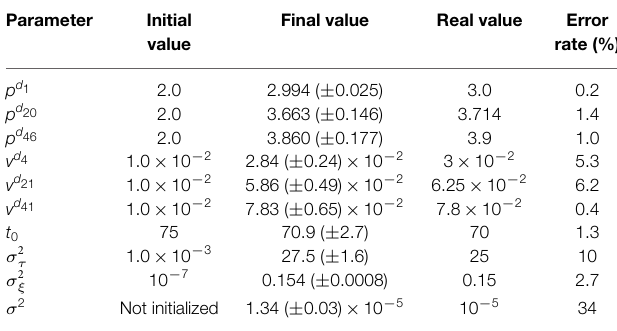
TABLE 1 | The table shows the ability of the algorithm to estimate the real value of the model